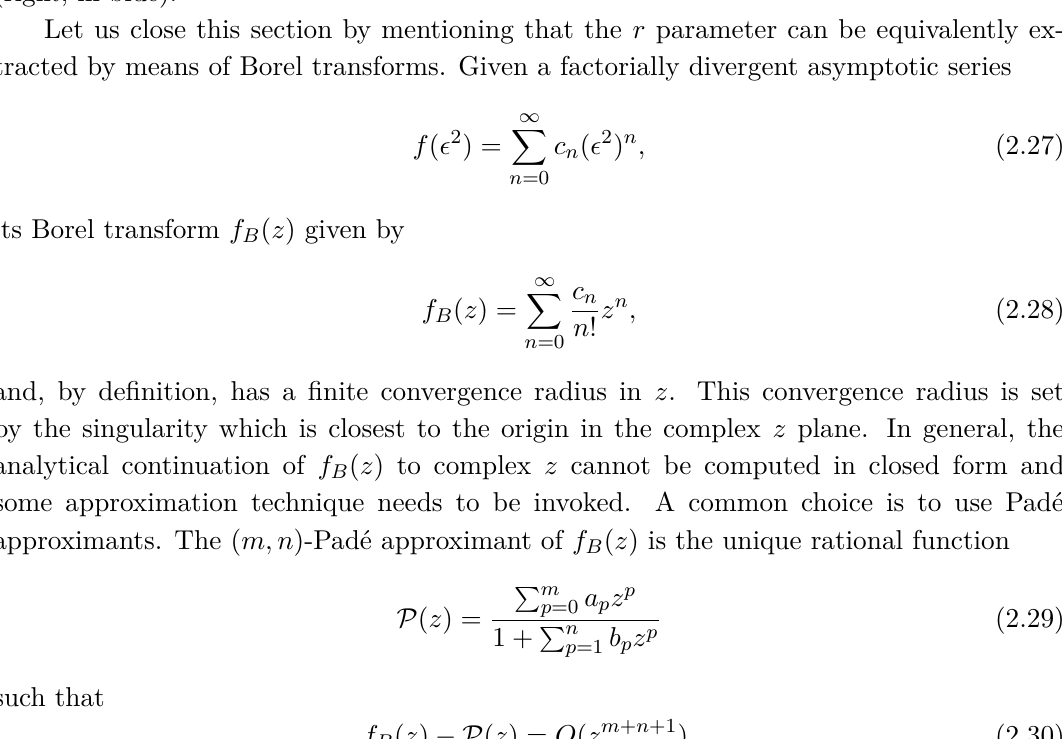
s = 1 / 4 (left) and s = 16 (center). These two curves, when re-scaled by 8 Dτ/s 2 and expressed as functions of 2 Dt/s 2 , collapse to a universal function, which agrees with (cid:22) ( (cid:17) ) (right, in